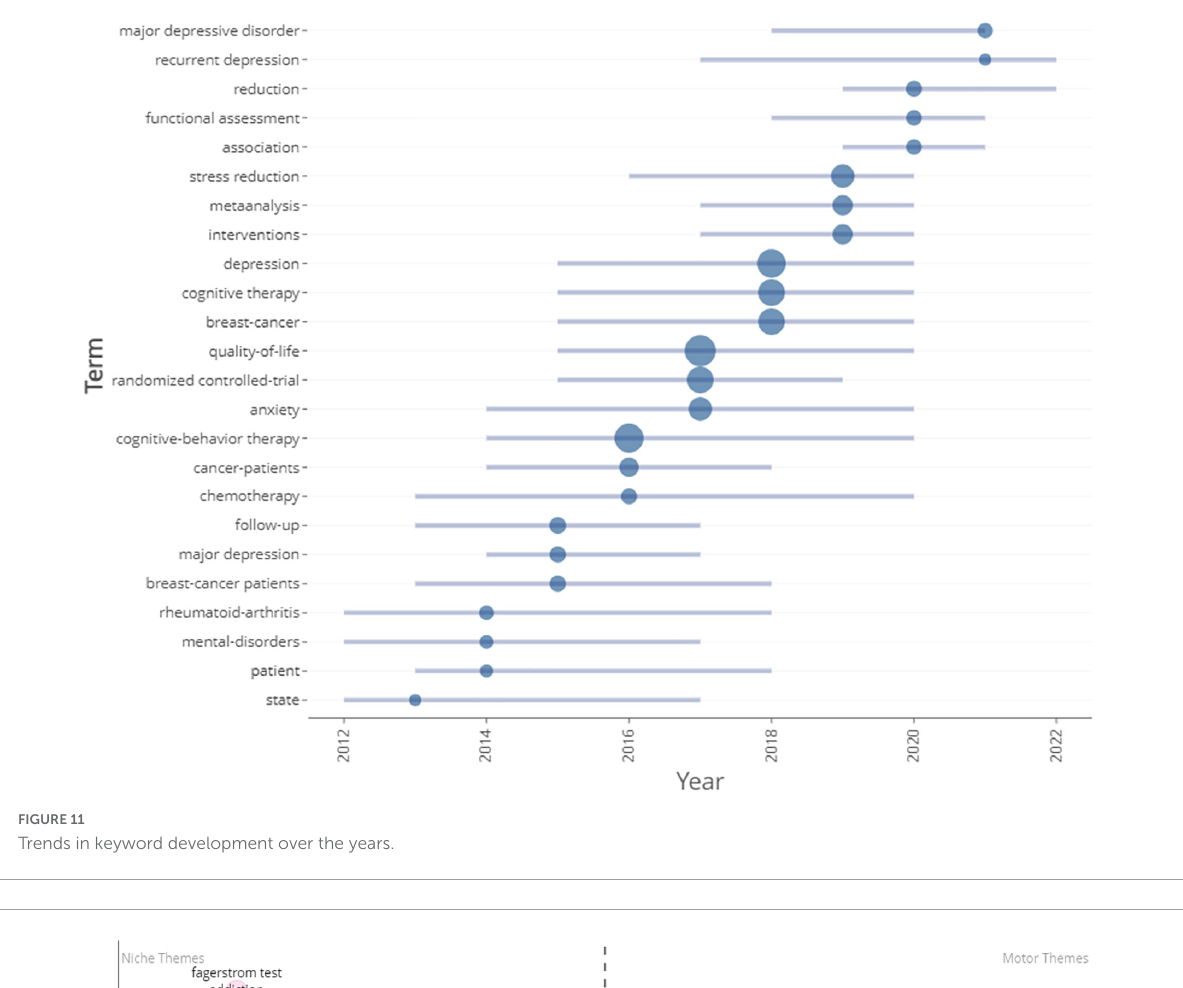
FIGURE11 Trends in keyword development over the years.